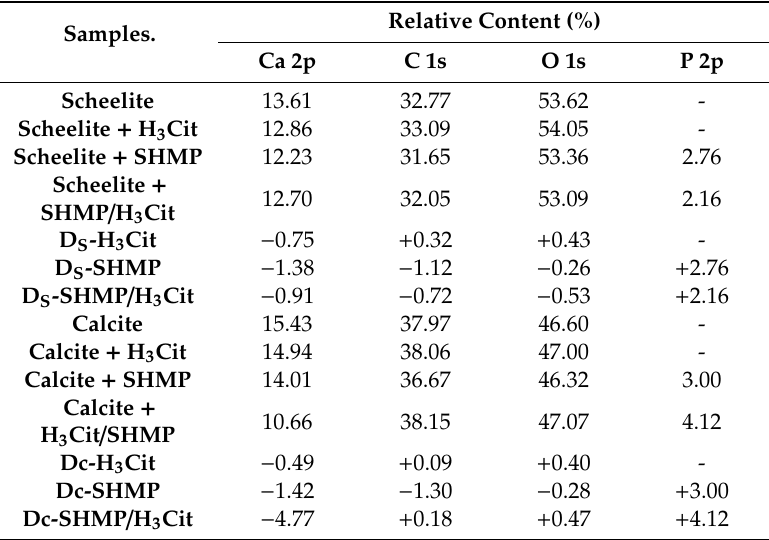
Table 8. Atomic relative content and the corresponding